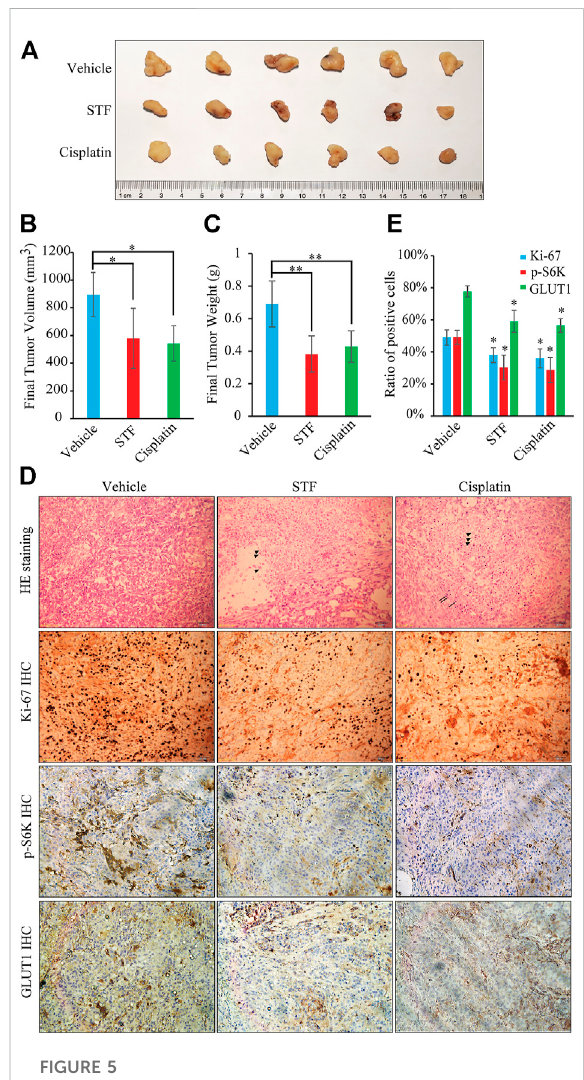
FIGURE 5 STF inhibited in vivo NSCLC tumor growth. (A) The antitumor activity of STF was evaluated in A549 cell-xenografted nude mice. The tumors were isolated by dissection and then photographed. (B,C) The fi nal tumor volumes (B) and tumor weights (C) in each group were determined. (D) The hematoxylin-eosin (H&E) and immunohistochemistry (IHC) staining in each group was imaged using a microscope. The scale bar represents 50 μ m. (E) The ratio of Ki-67, p-S6K, and GLUT1 positive cells in each group was compared statistically. Triangle: necrotic cells; Arrow: in fl ammatory cells. * p < 0.05, ** p <